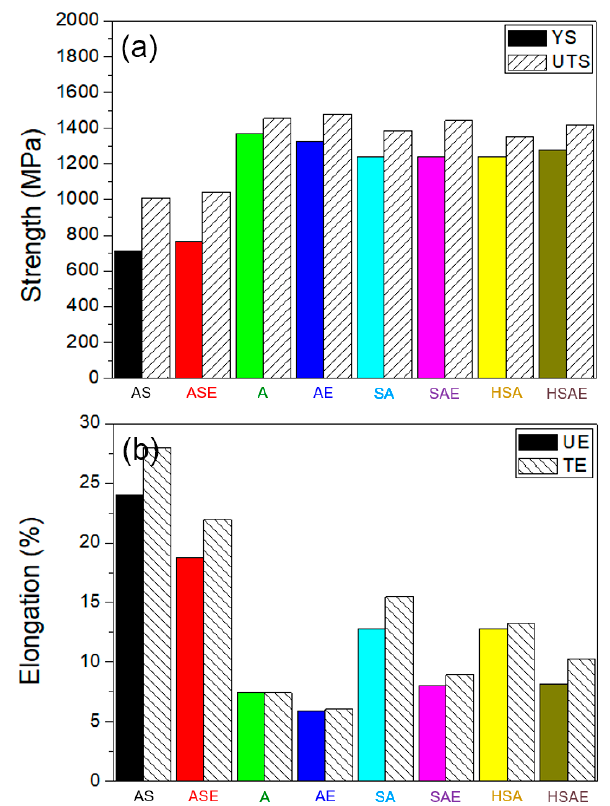
Figure 14. Tensile properties of specimen pre and post positive erosion: ( a ) strength, ( b ) ductility.